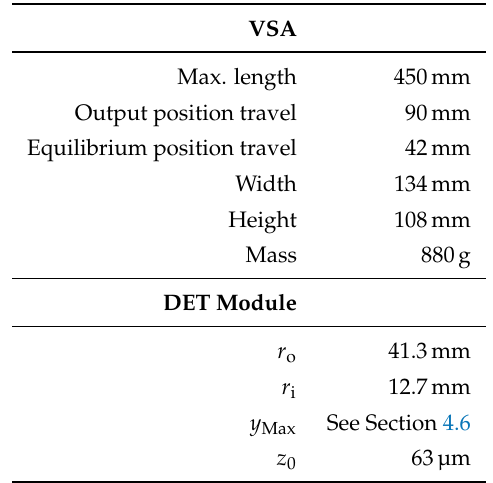
Table 1. Dimensions of our DET VSA and its DET